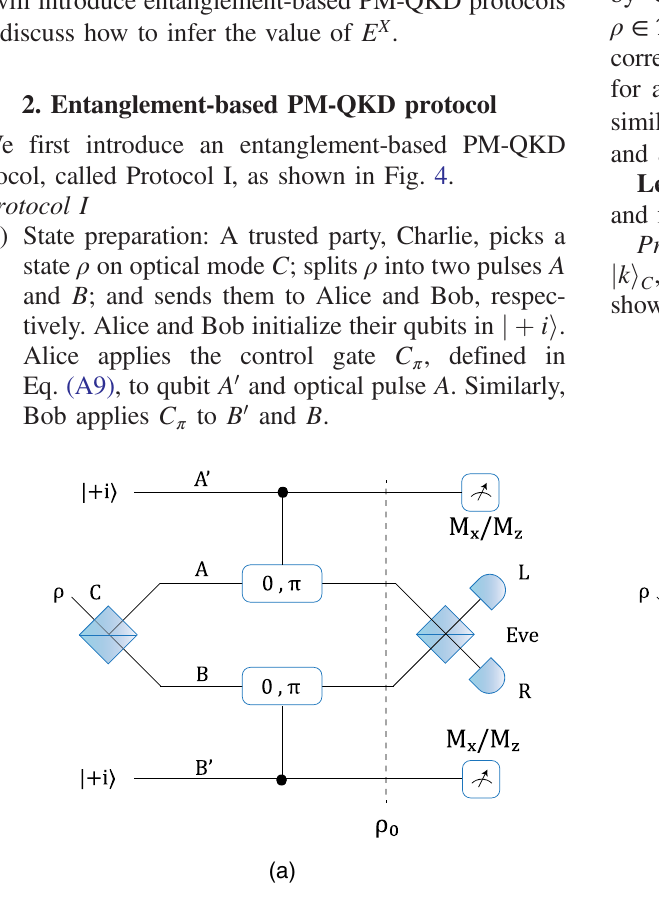
FIG. 4. (a) Schematic diagram of Protocol I. (b) Equivalent view of Protocol I, where the X -basis measurement on A 0 or B 0 is realized by a Hadamard gate followed by the Z -basis